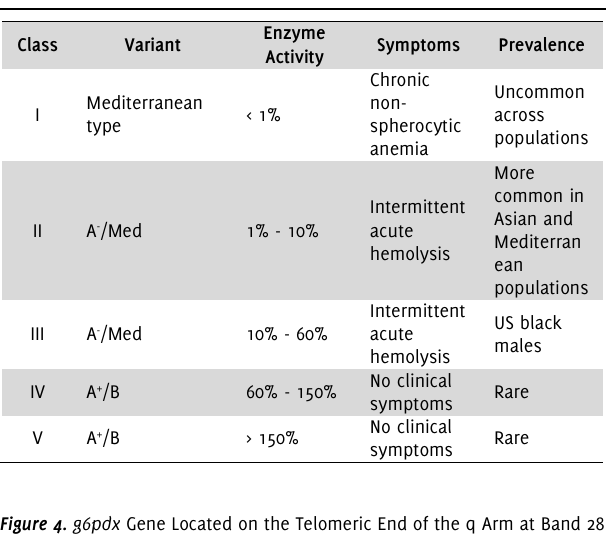
Table 1 . Classification of G6PD Deficiency.